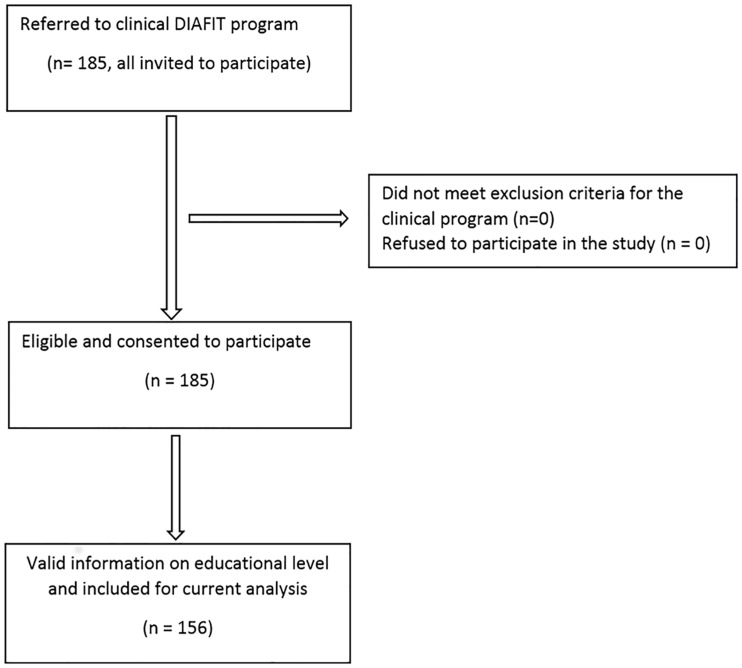
Description of the number of persons included and the number of patients used in our analysis.